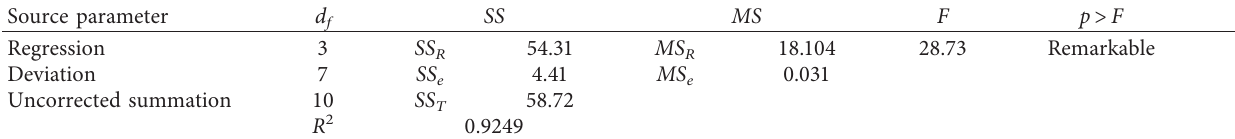
1 regression equation for compressive strength of mixed cement and gravel